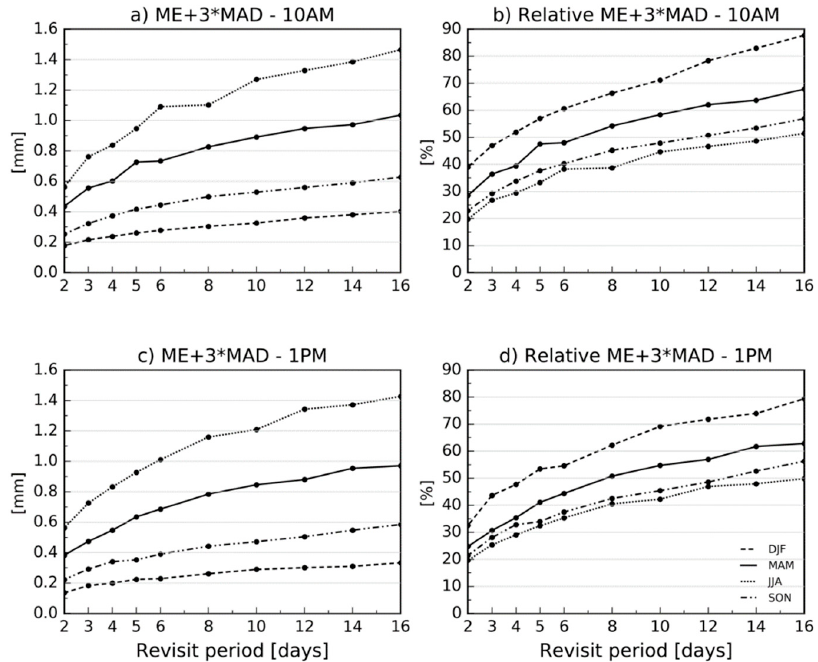
Figure 9. Maximum discrepancies (in mm per day)—expressed as the median error (ME) plus three median absolute deviations (MAD)—between the one-day revisit monthly ET dataset and four different revisit scenarios (2-day, 4-day, 8-day and 16-day revisit) for a 10:00 ( a , b ) and 13:00 ( c , d ) simulated satellite overpass time. The relative difference represents the ratio between the maximum discrepancy (i.e., ME+3*MAD) and the one-day revisit dataset.